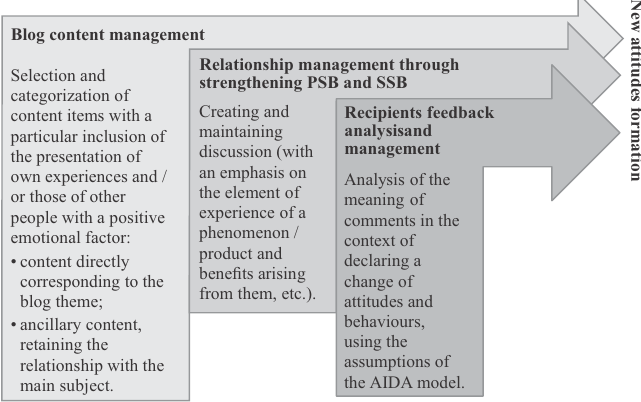
Fig. 4. Proposed model of blog content